Question: In one sentence, what is this figure communicating?
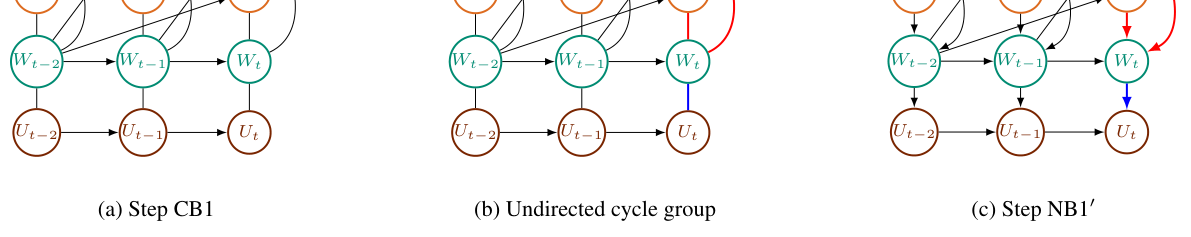
Answer: Illustration of the CBNB algorithm for the running example. (a) Output of the CB1 step (b) Detection of the undirected cycle group, where red and blue colours denote two different cycle groups of instantaneous nodes (c) Output of the NB1′ on each of the cycle groups.